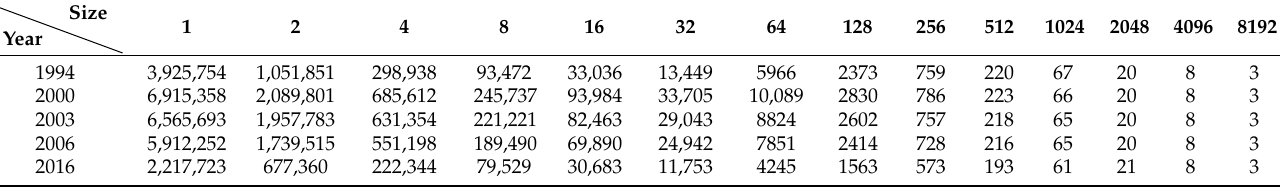
Table 5. Number of boxes in different years and box sizes for the rural